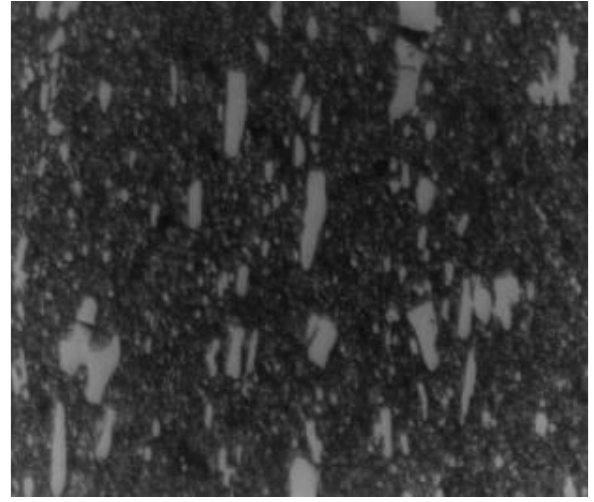
Figura 13. Ensaio 1; Z w = 6000 mm 3